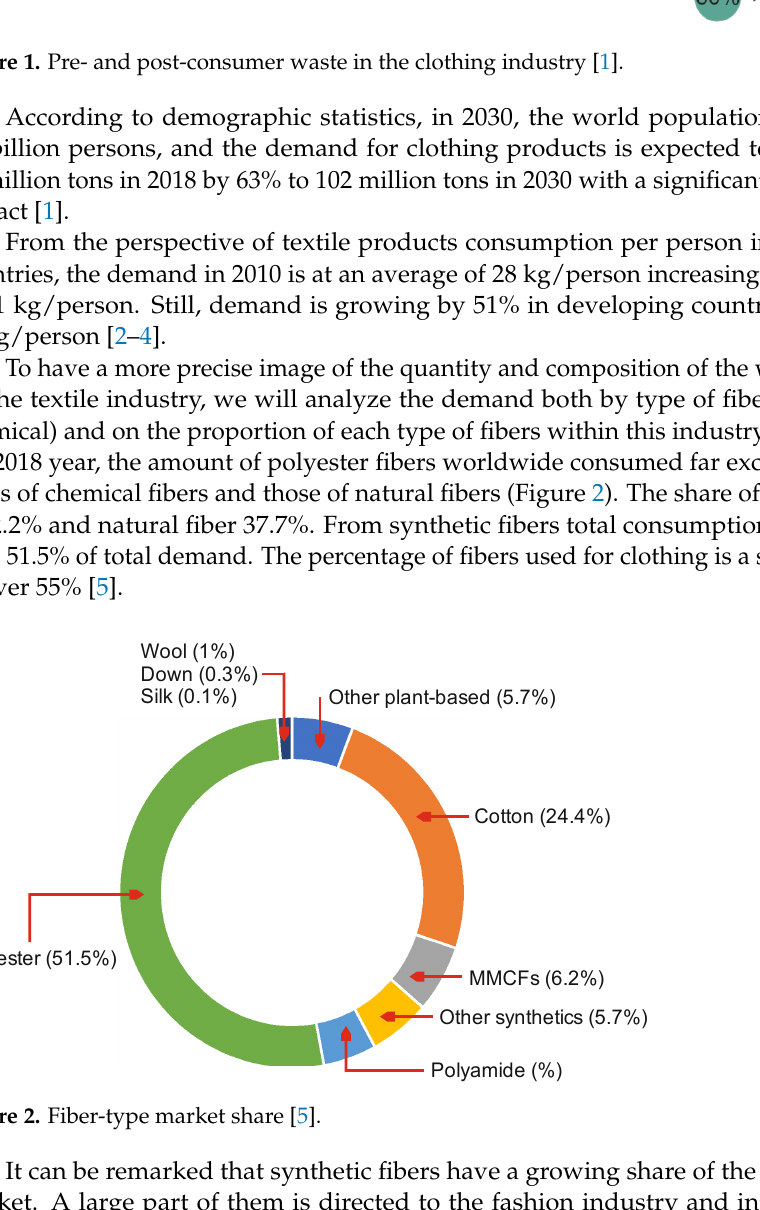
Figure 2. Fiber-type market share [5].